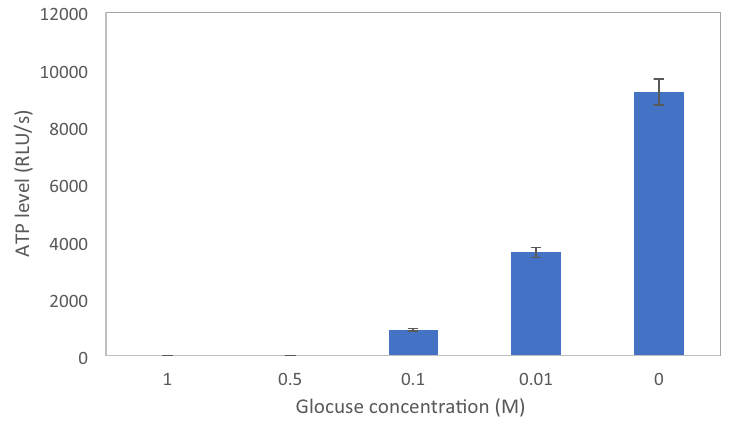
Figure 3. ATP levels after 23 h of incubation for ethanol production at different glucose concentrations in Z. mobilis crude extract. Values represent averages (n ≥ 3) and error bars represent 1